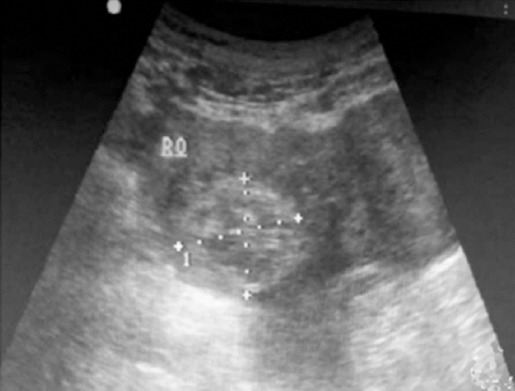
Results of transabdominal sonography: ectopic gestation mass with enhanced echo in adnexa area.